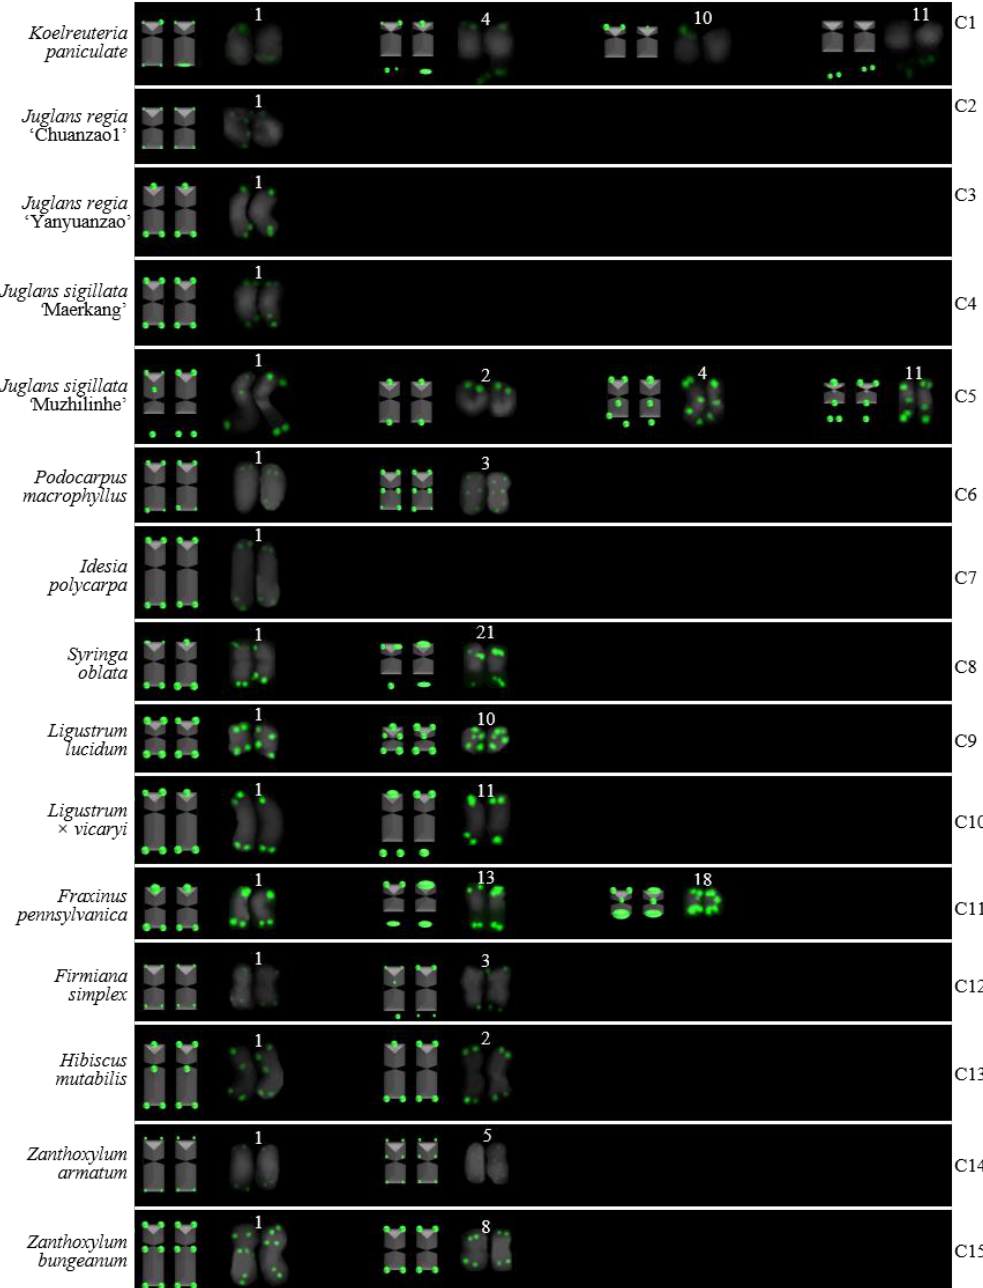
Figure 9. Ideograms of 15 woody plants based on the signal patterns in the FISH karyograms shown in Figure 6: ( C1 ) K. paniculata ; ( C2 ) J. regia ‘Chuanzao1’ ; ( C3 ) J. regia ‘Yanyuanzao’ ; ( C4 ) J. sigillata ‘Maerkang’; ( C5 ) J. sigillata ‘Muzhilinhe‘; ( C6 ) P. macrophyllus ; ( C7 ) I. polycarpa ; ( C8 ) S. oblata ; ( C9 ) L. lucidum ; ( C10 ) L. × vicaryi ; ( C11 ) F. pennsylvanica ; ( C12 ) F. simplex ; ( C13 ) H. mutabilis